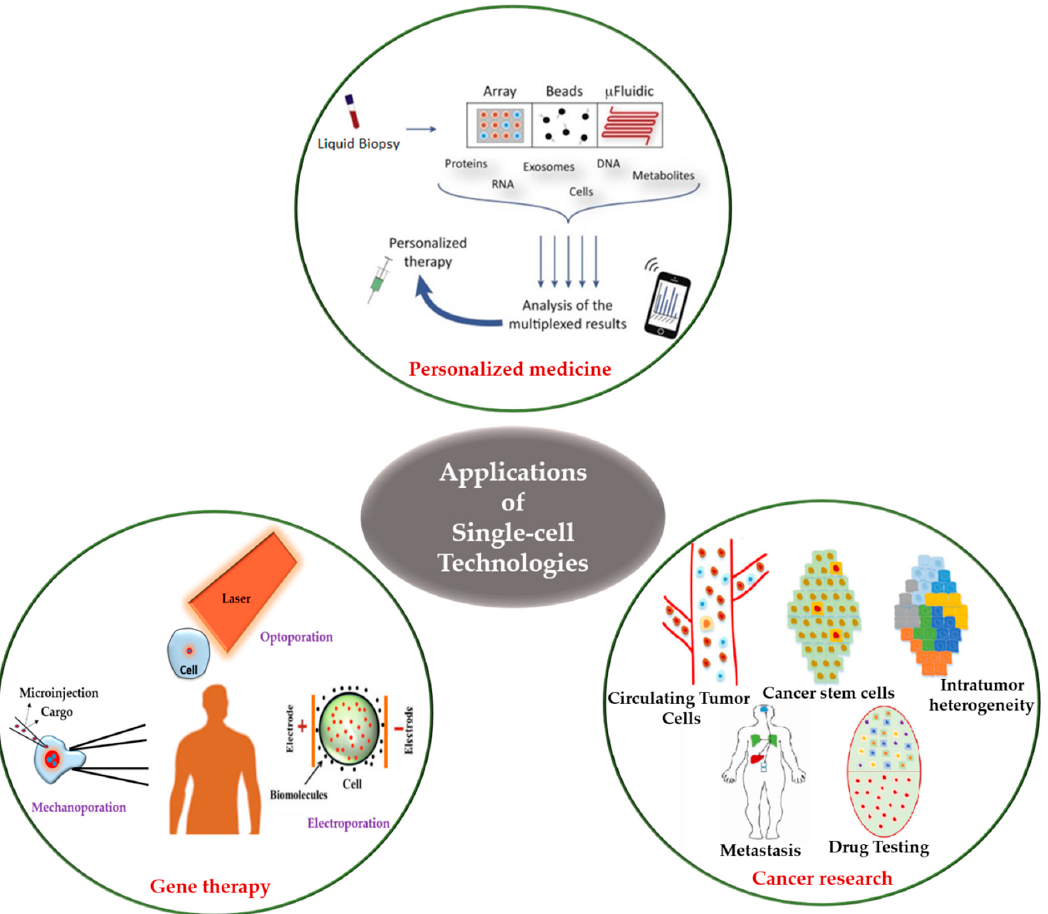
Figure 33. Applications of single-cell technologies. Reprinted with permission from [29,250].